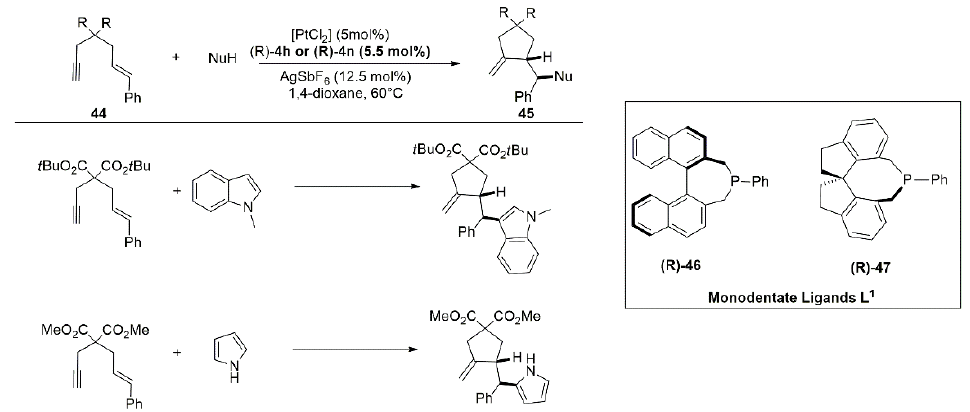
Figure 24 . Asymmetric hydroarylation/cyclization of 1,6-enynes ( 44 ).